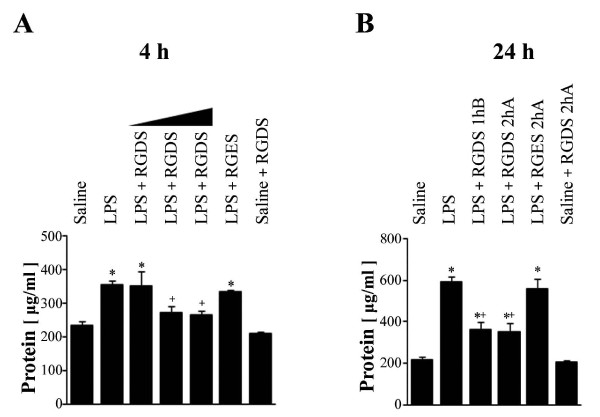
Effects of RGDS on LPS-induced increases in total protein levels in BAL fluid. Where indicated, mice were administered i.p. RGDS (1, 2.5 or 5 mg/kg) or RGES (5 mg/kg) once 1 h before LPS and sacrificed 4 h post-LPS (A). Mice were also administered these peptides (5 mg/kg, i.p.) once 1 h before or 2 h after LPS and were sacrificed 24 h post-LPS (B). Values represent means ± SEM of 5 mice per group. *Significantly different from saline treated controls, p < 0.05; +significantly different from animals treated with LPS only, p < 0.05.